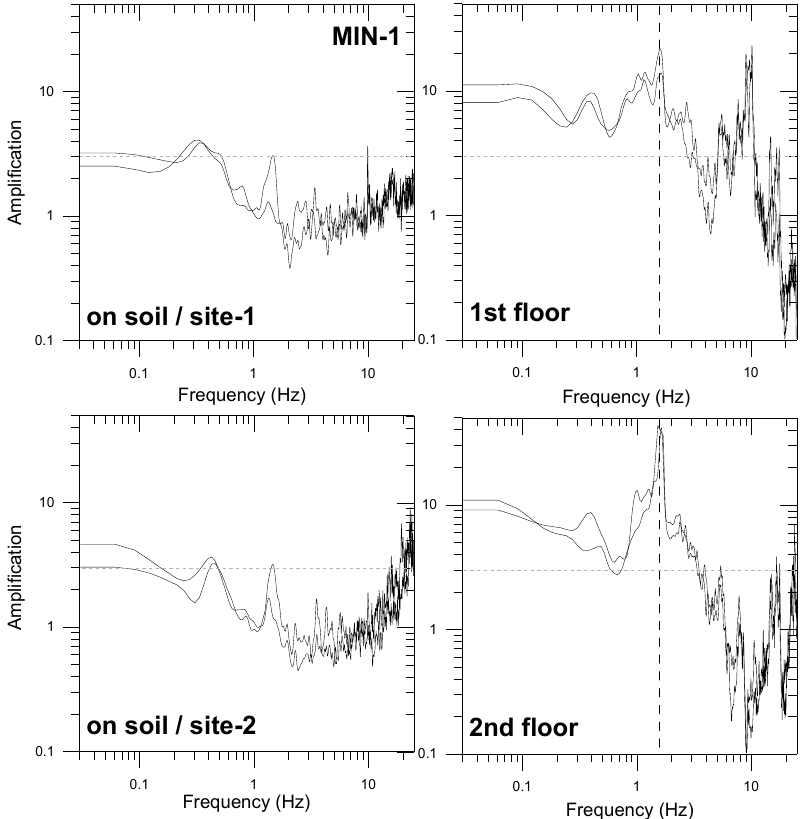
Figure 7. Average HVSR ratios at Suleiman Mosque on the soil and the two floors of the minaret [52].